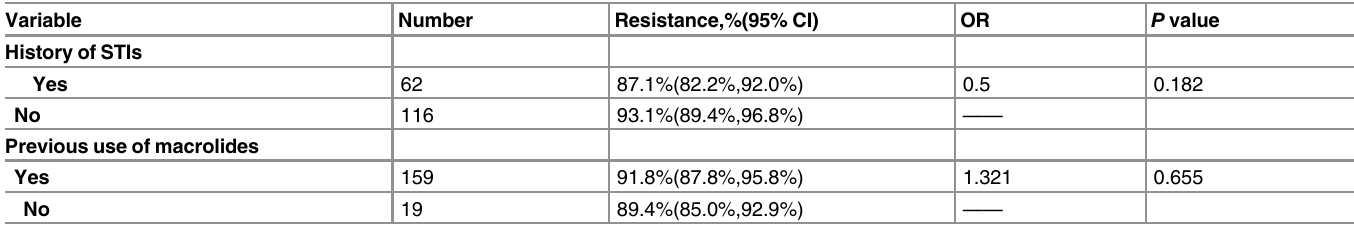
Table 4. History of STIs and macrolide use by patients (n = 178).